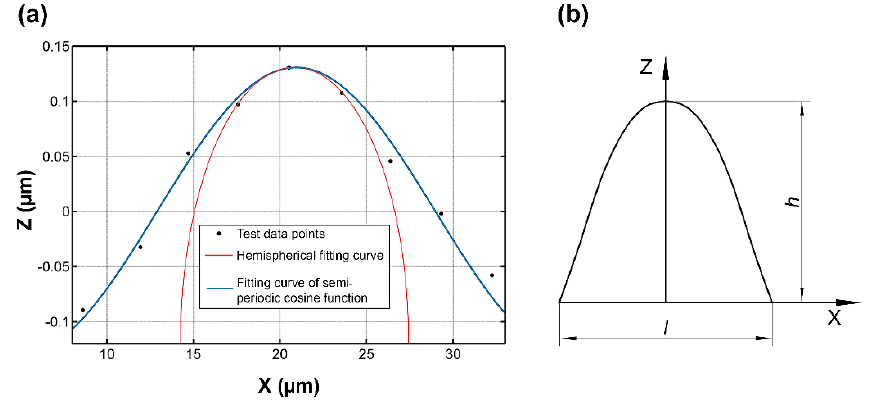
Figure 2. ( a ) Fitting results of measured data points using different fitting methods. ( b ) Vertical section image of a single asperity.